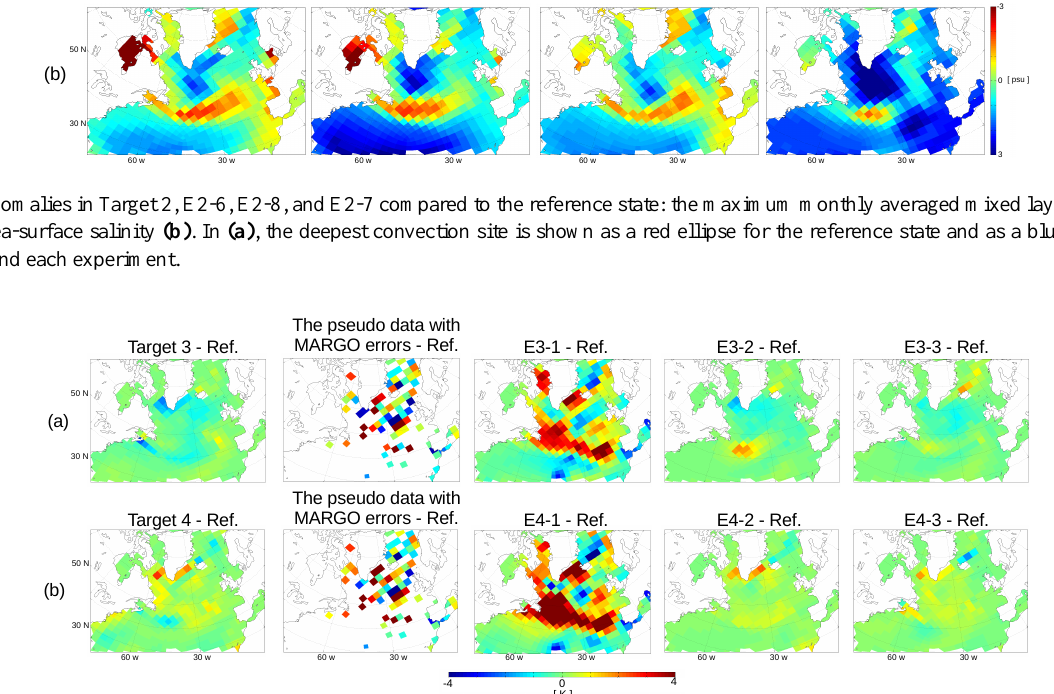
The pseudo data with MARGO errors - Ref. E4-1 - Ref. E4-3 - Ref.E4-2 - Ref. Target 4 - Ref.